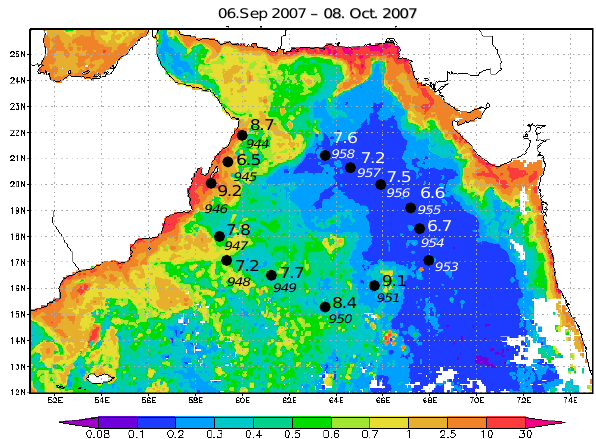
Fig. 1. Sampling locations in the Arabian Sea. Location numbers are in italic letters, large font indicates δ 15 N PN . Colours indicate chl a concentrations in mg m − 3 from satellite observations between 6 September and 8 October 2007, available from http://gdata1.sci.